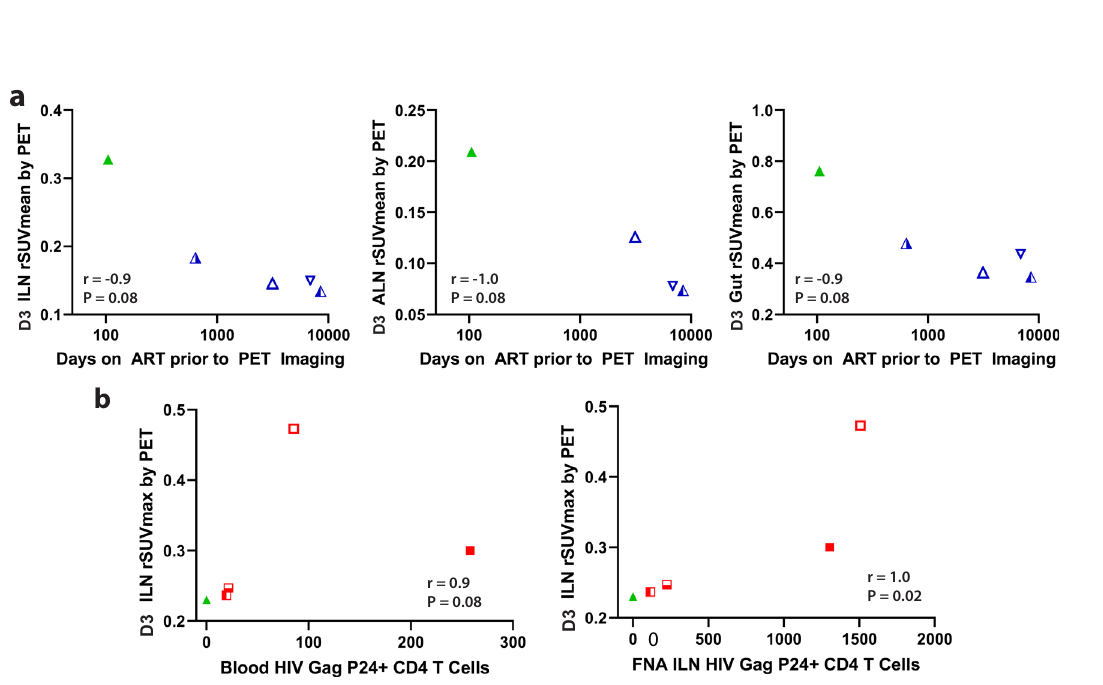
Fig. 6 Associations between time on ART, HIV p24 protein expression in lymph node CD4 T cells obtained by tissue biopsy, and tracer uptake in various anatomical regions. Correlations between 89 Zr-VRC01 rSUVmean in lymph node and gut tissues on imaging day 3 compared with days on ART for viral suppressed participants are shown in a . b Correlations between 89 Zr-VRC01 rSUVmax/mean and the frequency of blood and inguinal lymph node HIV Gag P24 + CD4 + T cells as measured by fl ow cytometry. r and P values represent results from Spearman correlation analyses. Overall, inverse associations between tracer uptake and ART duration and a signi fi cant positive correlation between inguinal lymph node 89 Zr-VRC01 uptake and direct measures of HIV protein expression in CD4 T cells from inguinal lymph node sampling were observed. Source data are provided as a Source Data fi